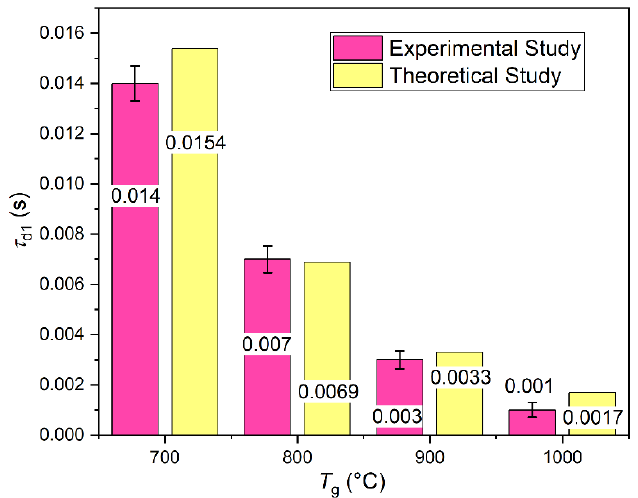
Figure 2. Double gas hydrate ignition delay times under radiative heating with varying heating source temperature T g from 700 to 1000 °C (hydrate particle size R d = 0.25